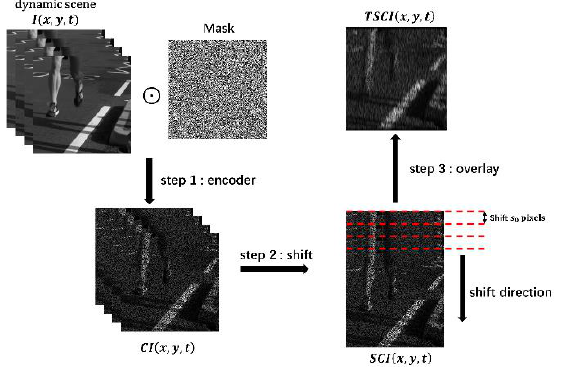
Figure 3. Data compression flowchart for CUP.